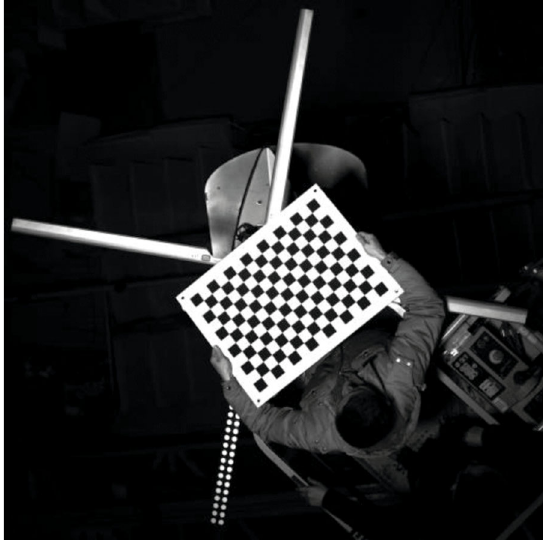
Figure 8: An example of the camera calibration